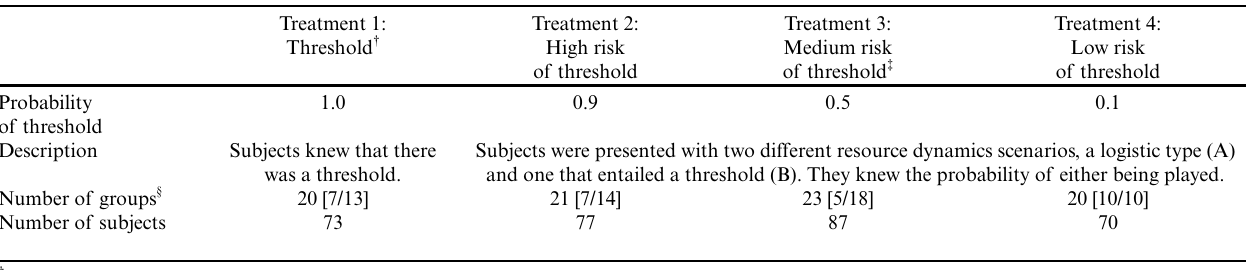
Table 1 . Experimental